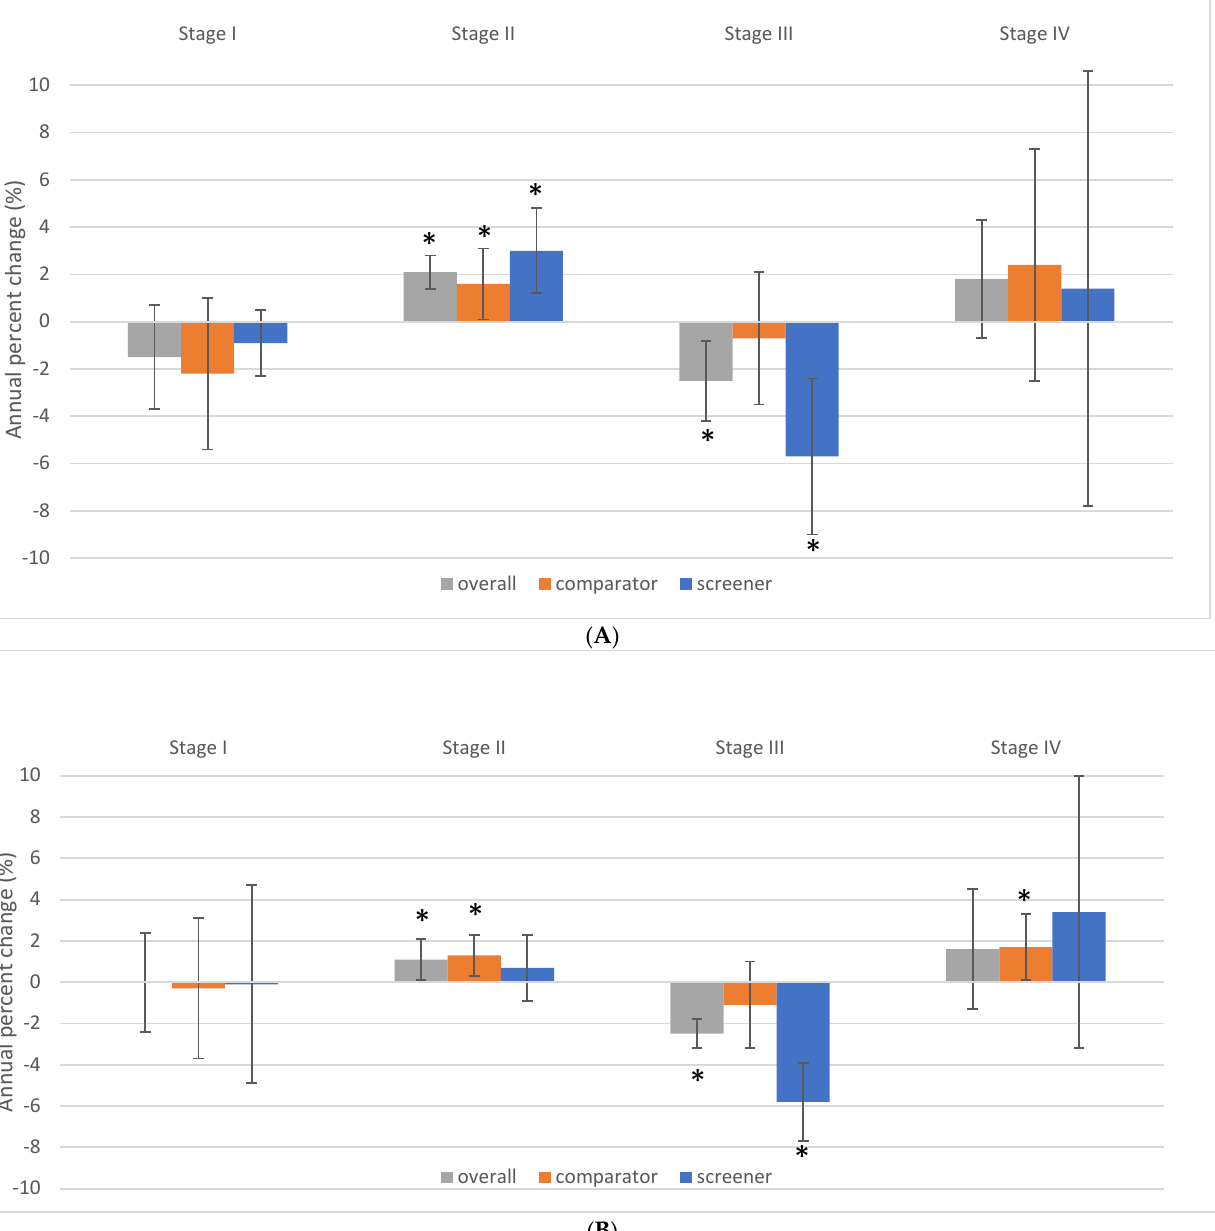
Figure 5. ( A ). Stage–specific female breast cancer incidence rate trends by jurisdictional screening status, ages 40 to 49 years, Canada excluding Quebec, 2011 to 2017. ( B ). Stage-specific female breast cancer incidence rate trends by jurisdictional screening status, ages 50 to 59 years, Canada excluding Quebec, 2011 to 2017. Note: Quebec is excluded because cases diagnosed in Quebec from 2011 onward had not been submitted to the Canadian Cancer Registry. Screeners: Alberta, British Columbia, Nova Scotia, Northwest Territories, and Prince Edward Island; Comparators: Manitoba, New Brunswick, Newfoundland and Labrador, Nunavut, Ontario, Saskatchewan, Yukon. The vertical error bars indicate 95% confidence intervals. Asterisks indicate the trend is significant at the p < 0.05 level. Source: Canadian Cancer Registry (1992 to 2018) at Statistics Canada [42]; provincial and territorial screening practices [49,50].